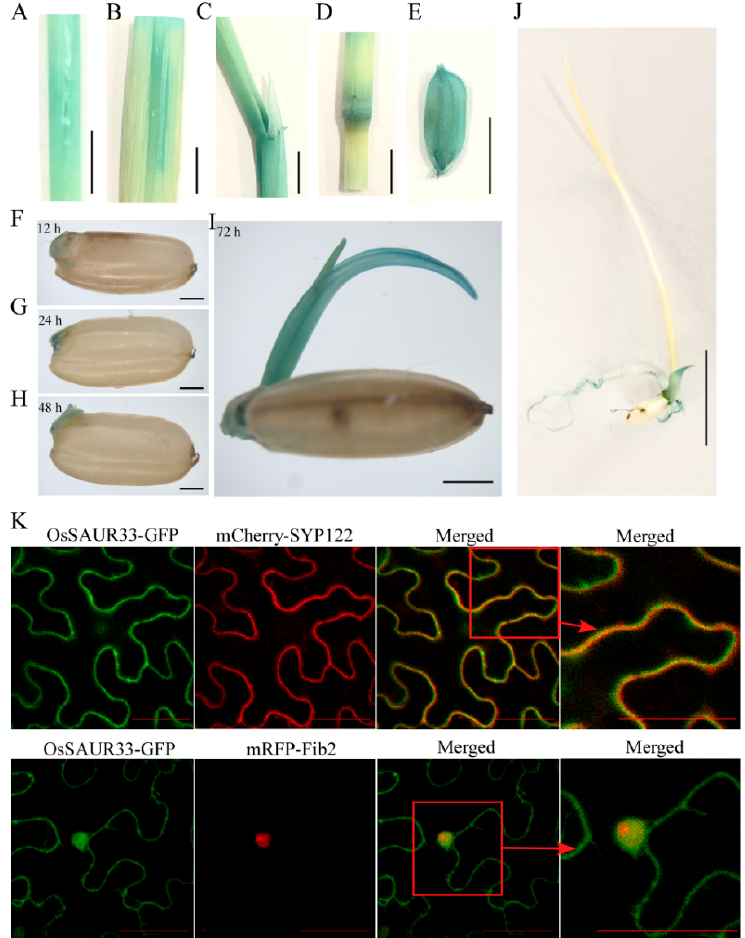
Figure 3. β -Glucuronidase (GUS) activity of the OsSAUR33 promoter and its subcellular localization in rice. ( A – J ) Histochemical staining for GUS activity in various tissues and germinating seeds. Bar = 1 cm ( K ) Subcellular localization of OsSAUR33 in N. benthamiana leaves. The localization of mCherry-SYP122, a plasma membrane (PM) marker, and mRFP-Fib2, a nucleus marker, is shown in red, and OsSAUR33 fusion proteins is shown in green. The red box indicates the higher magnification image of localization. Fluorescence signals were observed at 48 h after infection. Bar = 50 μ m.